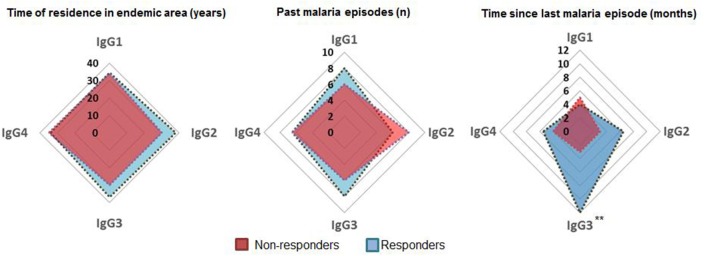
Comparison of exposure parameters between responders and non-responders for IgG subclasses. Medians of time of residence in endemic area (TREA), past malaria episodes (PME), and past months since last infection (TLME) for positive and negative individuals tested for IgG and subclasses were compared. Positive individuals tested for IgG3 presented a higher median of TLME. **p < 0.01.